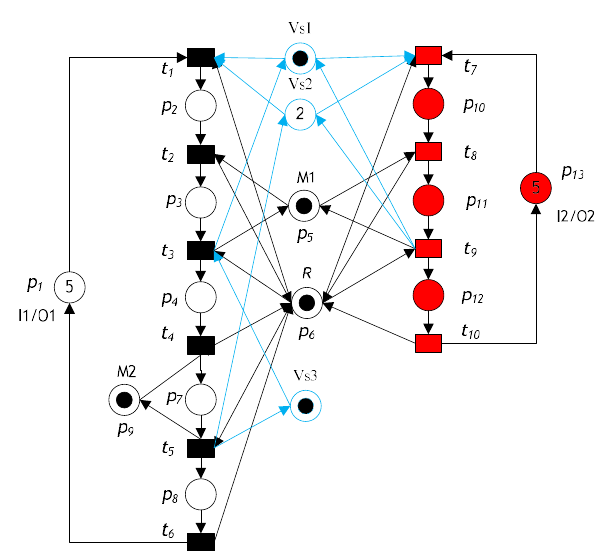
Figure 9. Controlled reconfigurable S 3 PR net by addition of new product.